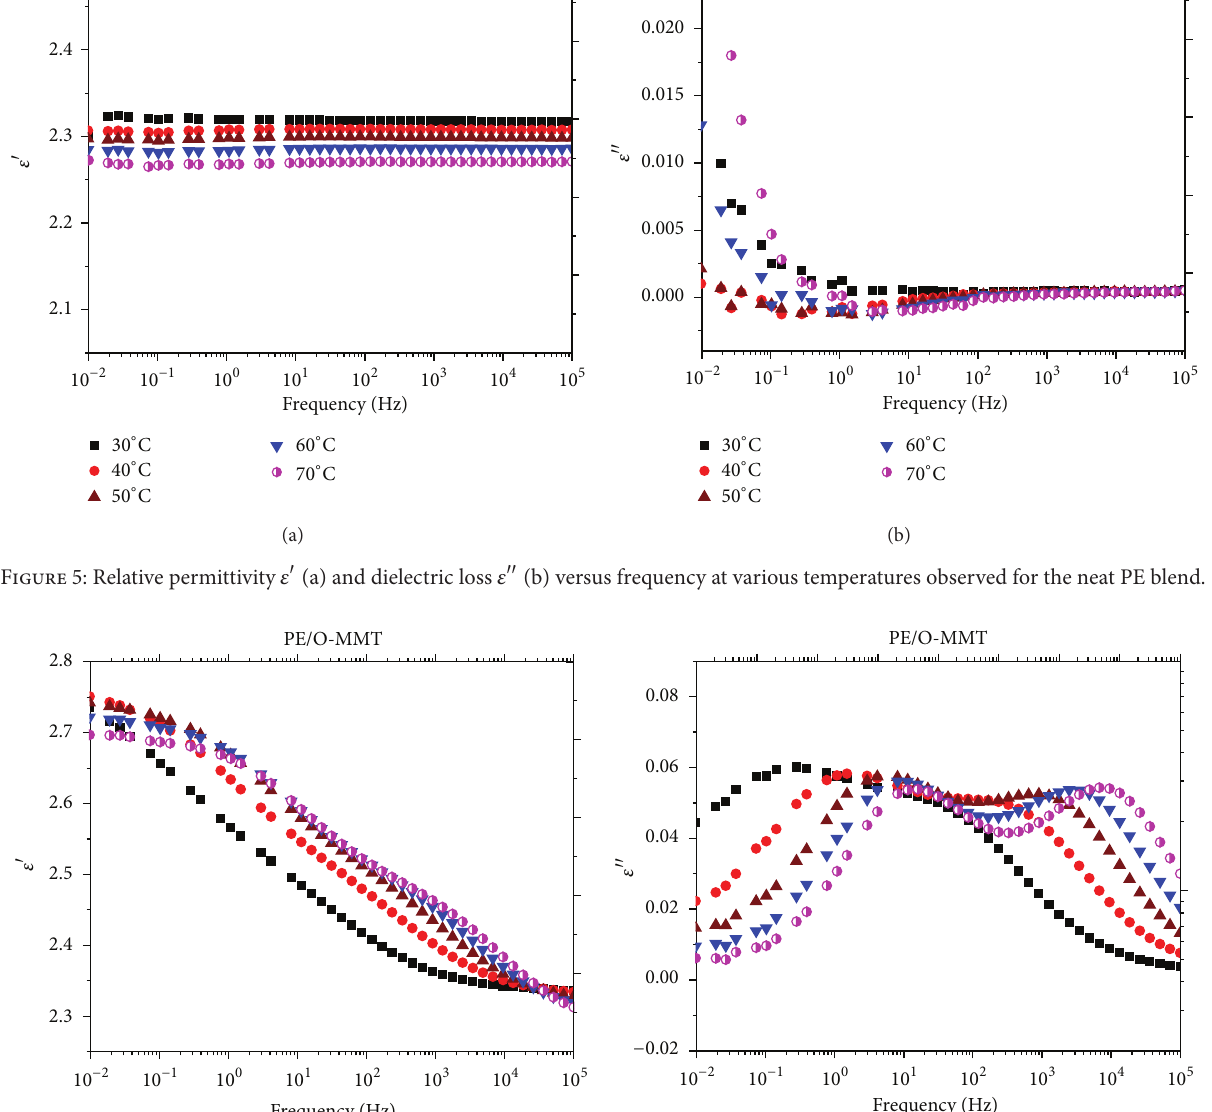
montmorillonite clay in order to improve compatibility and dispersion of the hydrophilic clay within the hydrophobic polymer